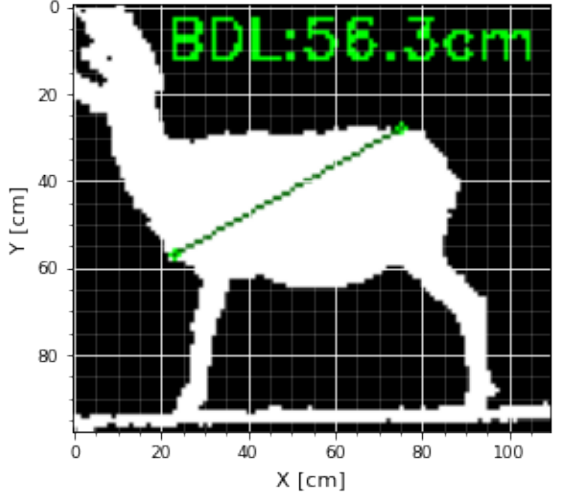
Figure 10. Example of BDL obtained by the Kinect ®